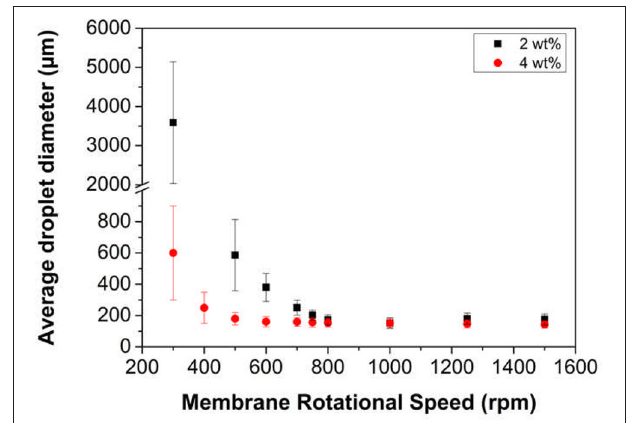
FIGURE 6 | Variation in mean droplet size of hexadecane in water emulsions as a function of membrane rotation speed at 2 and 4 wt% particle loading of LP-DMAEMA 245 . The continuous phase contained an electrolyte concentration of 0.01M KNO 3 at pH 9. The oil injection rate was fixed at 0.01mL min − 1